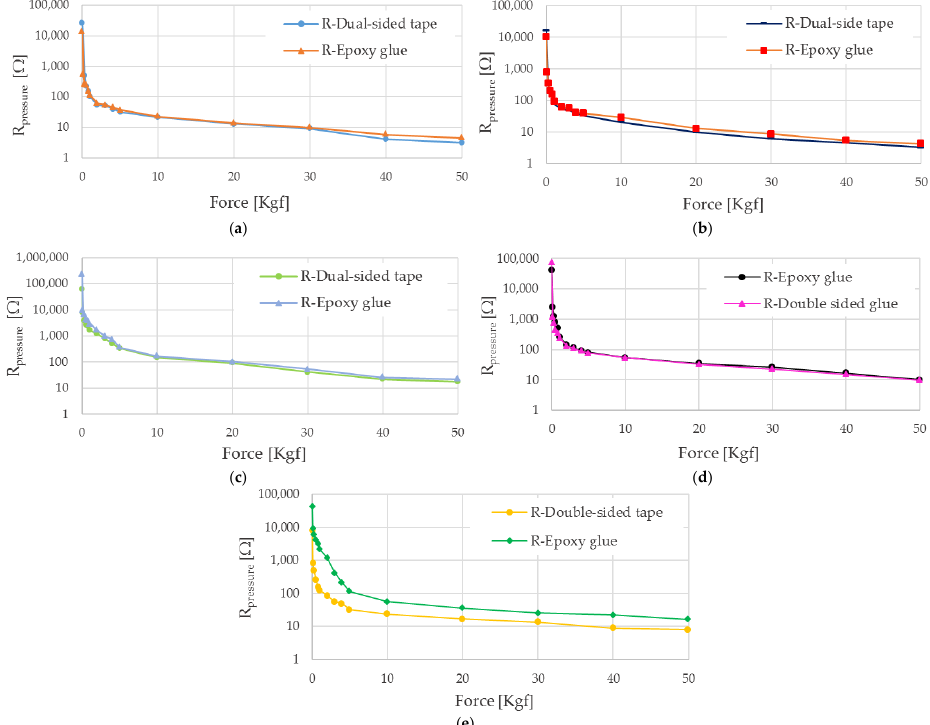
Figure 17. Characteristics R vs. F (expressed in Kgf) for five Velostat-based pressure sensors (logarithmic scale): sensor 1 (3 cm × 3 cm) ( a ); sensor 2 (3 cm × 3 cm) ( b ); sensor 3 (1 cm × 1 cm) ( c ); sensor 4 (1 cm × 1 cm) ( d ); and sensor 5 (3 cm × 1 cm) ( e ).